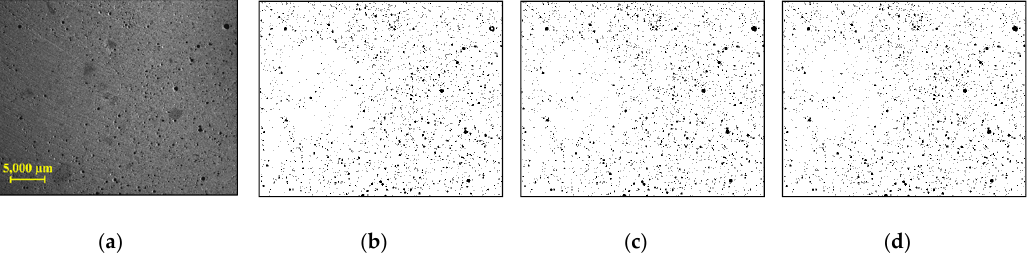
Figure 5. PCM1-1: ( a ) microscopic image; ( b – d ) binary images using 50 × 50, 100 × 100, and 200 × 200 windows, respectively.